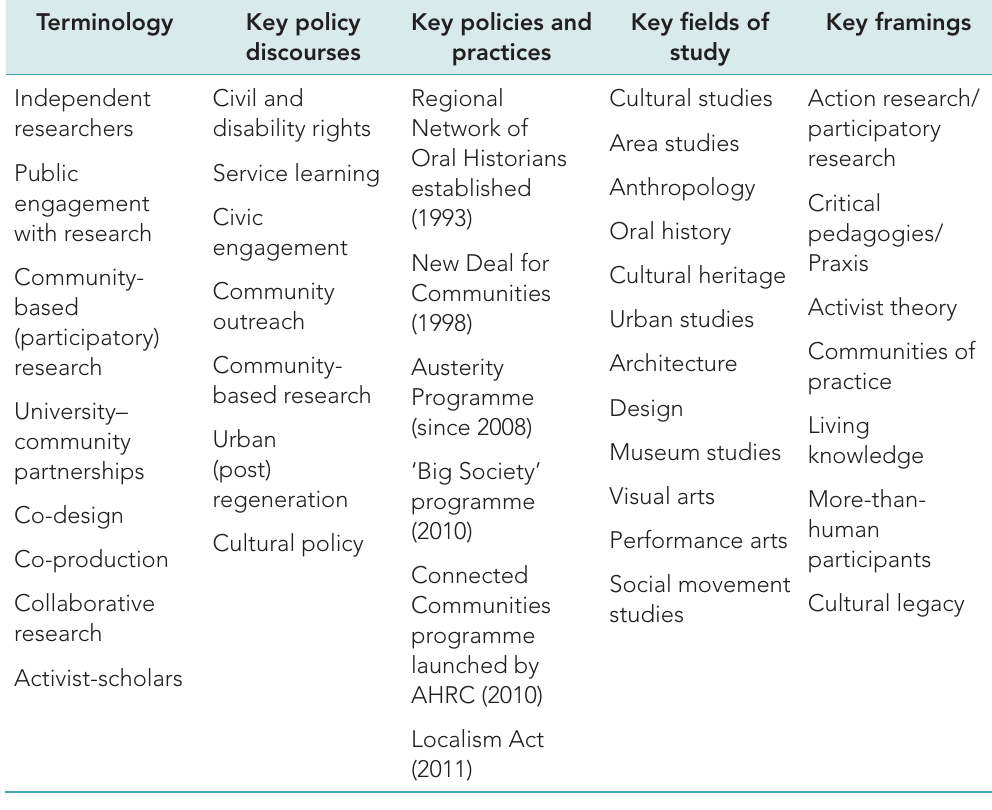
Table 5: Approaches to research engagement within the community development